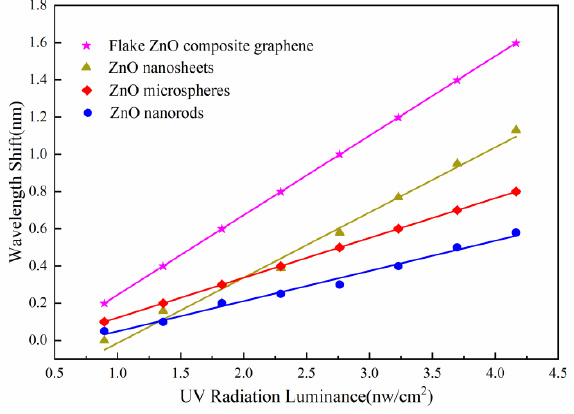
Figure 4. The wavelength shift versus ultraviolet radiation luminance for sensors. Table 1. The results of the linear fitting of STMS coated ZnO and ZnO composite graphene.